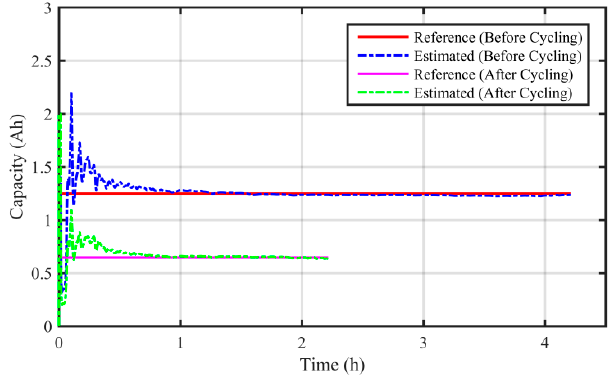
Figure 7. Monitoring results of capacity decay with the proposed method.